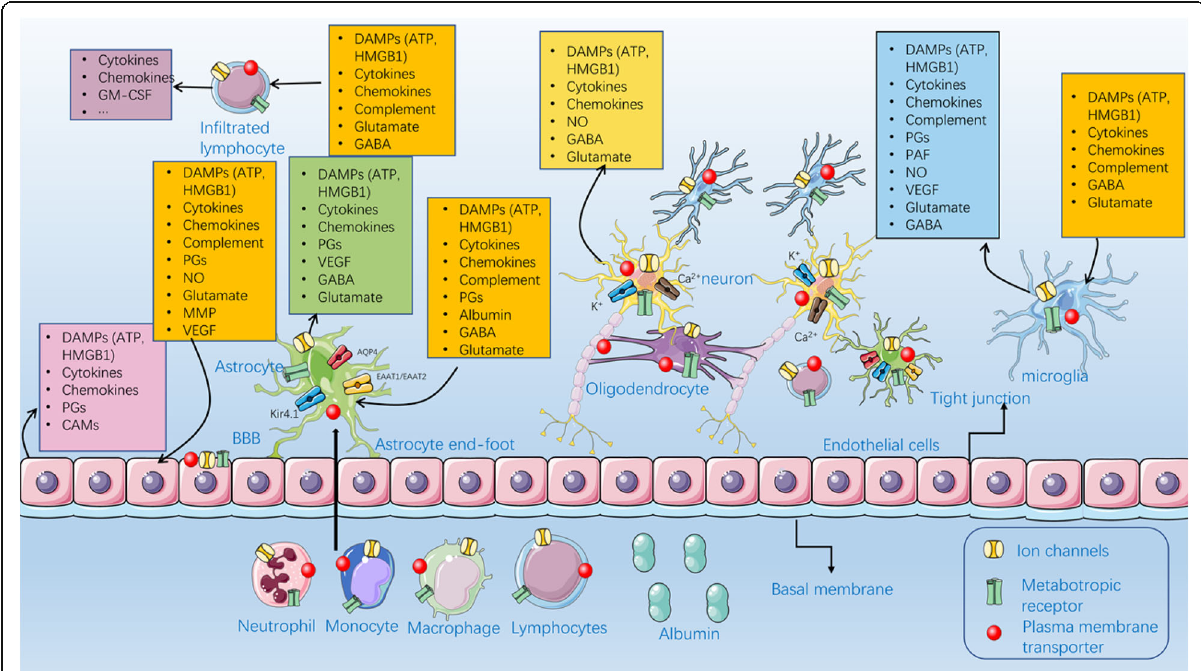
Fig. 3 Illustration of main targets and sources of pro-ictogenic inflammatory mediators in the brain. The pro-inflammatory molecules can either be produced by brain cells or produced by infiltrating lymphocytes after epileptogenic events. These inflammatory mediators promote the transcription and release of other inflammatory molecules in autocrine and/or paracrine manners, and also induce or aggravate the blood-brain barrier (BBB) dysfunction. Some of them can trigger neuronal over-excitation by disturbing the gliotransmitter metabolism in astrocytes. Besides, they can directly activate their cognate receptors on neurons to induce alterations of expression of glutamate and GABA receptors as well as ion channels. All these pro-inflammatory mediators alter synaptic transmission and promote excitotoxicity, thereby contributing to pathological outcomes. DAMPs: damage-associated molecular pattern molecule; NO: nitric oxide; PAF: platelet-activating factor; PG: prostaglandin; MMP-9: matrix metalloproteinase-9; VEGF: vascular endothelial growth factor; GABA: γ -aminobutyric acid; GM-CSF: granulocyte-macrophage